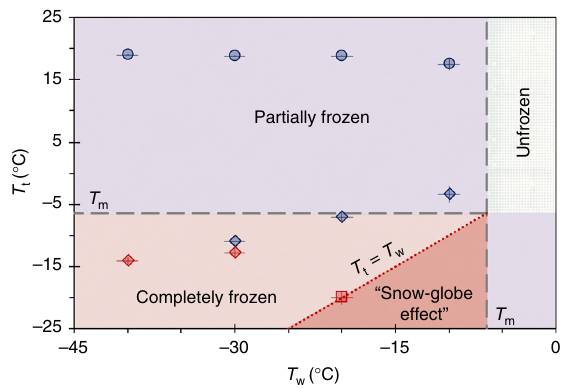
Fig. 7 Regime map of different kinds of freezing behavior in soap bubbles. Bubbles completely freeze in the red regions ( T t < T m and T w < T m ), while a partially frozen equilibrium occurs for bubbles in the purple area ( T t > T m ). The dark red region is a subset of the “ Completely Frozen ” regime, where the Marangoni freezing is able to produce the “ Snow-Globe Effect ” due to the added criterion of T t ≤ T w . Blue and red data points correspond to experimentally observed partially frozen or completely frozen bubbles, respectively, where the enclosed air volumes were 5 μ L (diamonds), 500 μ L (circles), or 10 mL (squares). Long dashed lines correspond to T t = T m and T = T w m , while the dotted line corresponds to using an isothermal